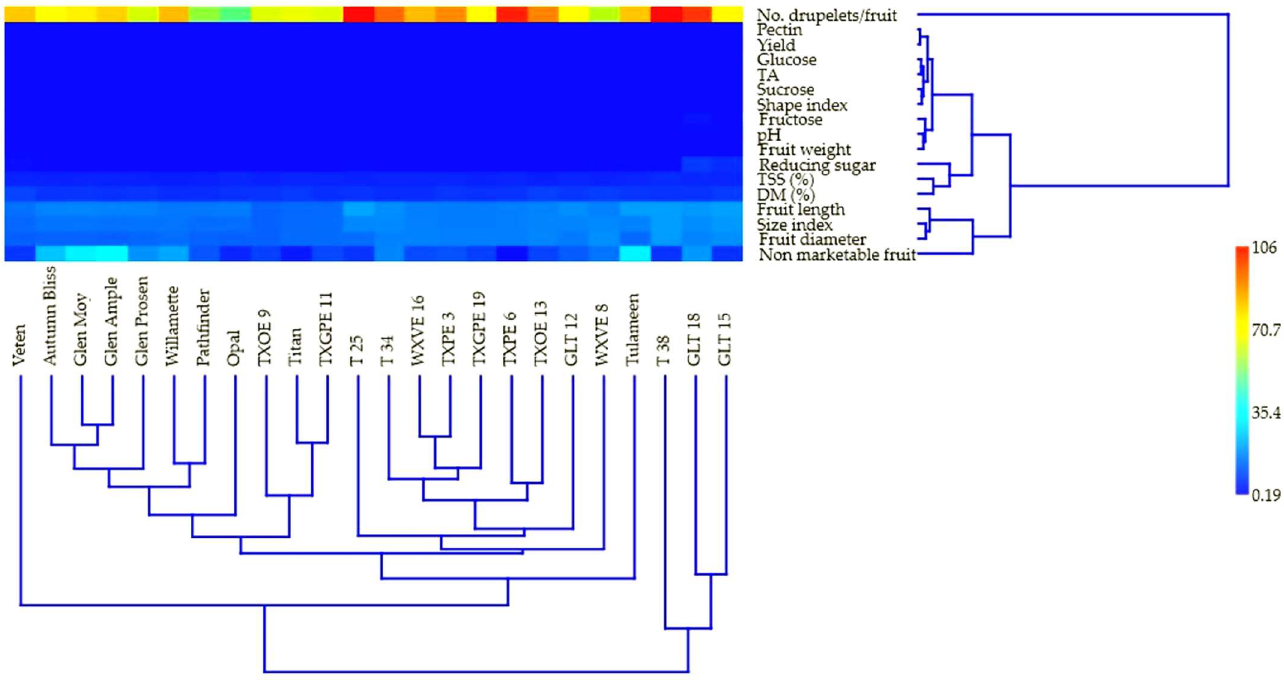
Figure 5. Hierarchical clustering analyses of the 24 raspberry genotypes (14 promising selections, their parents, and Glen Ample cultivar as control) based on 17 analyzed characteristics assessed via paired group UPGMA, the Gover similarity index. DM represents dry matter, TSS represents total soluble solids, and TA represents titratable acidity.